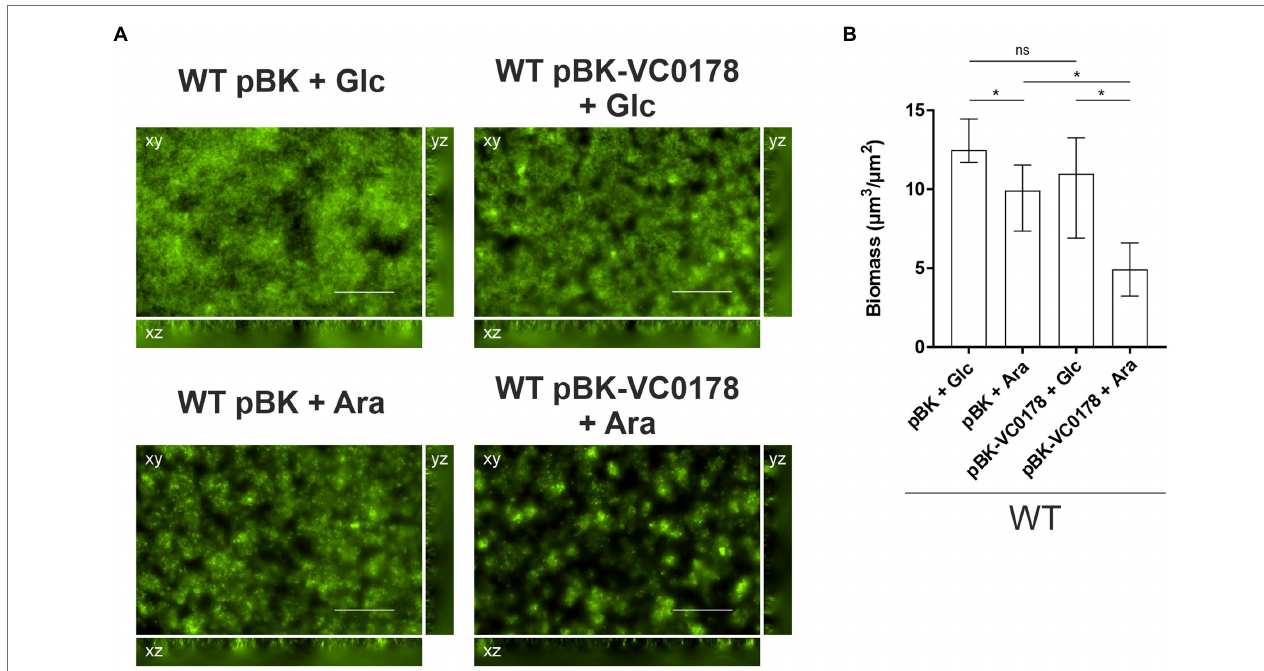
FIGURE 6 | Timed induction of ibr gene VC0178 results in dispersal of mature biofilms. (A) Fluorescent microscopy images of SYTO ™ 9 stained biofilms as horizontal (xy) and vertical (xz and yz) projections (large and side panels, respectively) of WT with empty vector (pBK) and WT with pBK-VC0178, as indicated. All biofilms were initially grown for 16 h in flow cell chambers with constant 2% LB-Km/Glc medium flow, and then for 8 more hours with constant flow of fresh 2% LB-Km/Glc medium or 2% LB-Km/Ara, as indicated above each image. Optical sectioning was performed in 0.5 μ m steps. Scale bar = 50 μ m. (B) Image stacks of WT pBK and WT pBK-VC0178 were analyzed using the COMSTAT software (http://www.comstat.dk; Heydorn et al., 2000; Vorregaard, 2008) to quantify their total biomass. Represented are the medians ± IQR of at least eight image stacks from three independent experiments for each strain. Significant differences are indicated by an asterisk (* p < 0.05 Kruskal–Wallis test followed by post hoc Dunn’s multiple